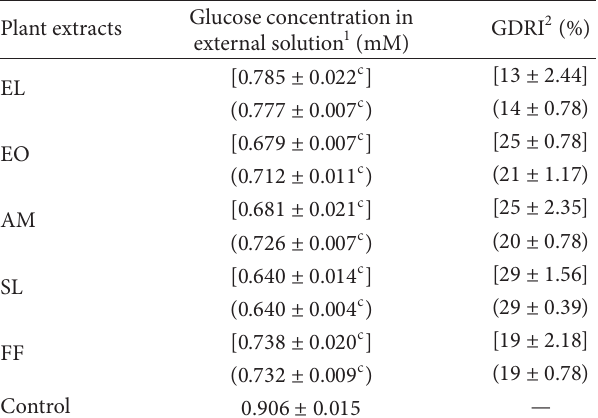
Table 5: Glucose concentration in external solution and glucose diffusion retardation index of methanolic plant extracts after 4 h. Glucose concentration in Plant extracts